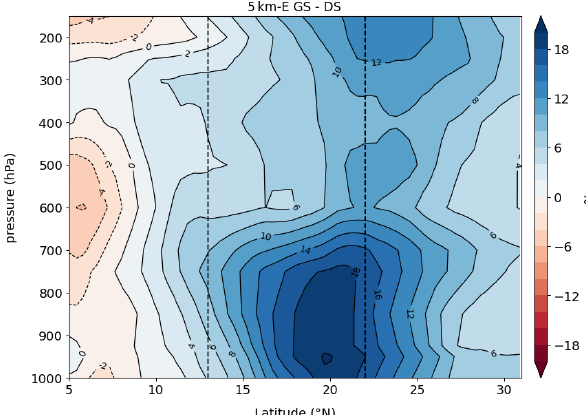
Figure 7. Vertical cross section of the difference in relative humid- ity between the GS and the DS simulation for the 5km-E simula- tions. The field is averaged over the WA domain outlined in Fig. 1. The vertical dashed lines delineate the latitudes of the coastal, the Sahel, and the Sahara domain (see Fig. 1).